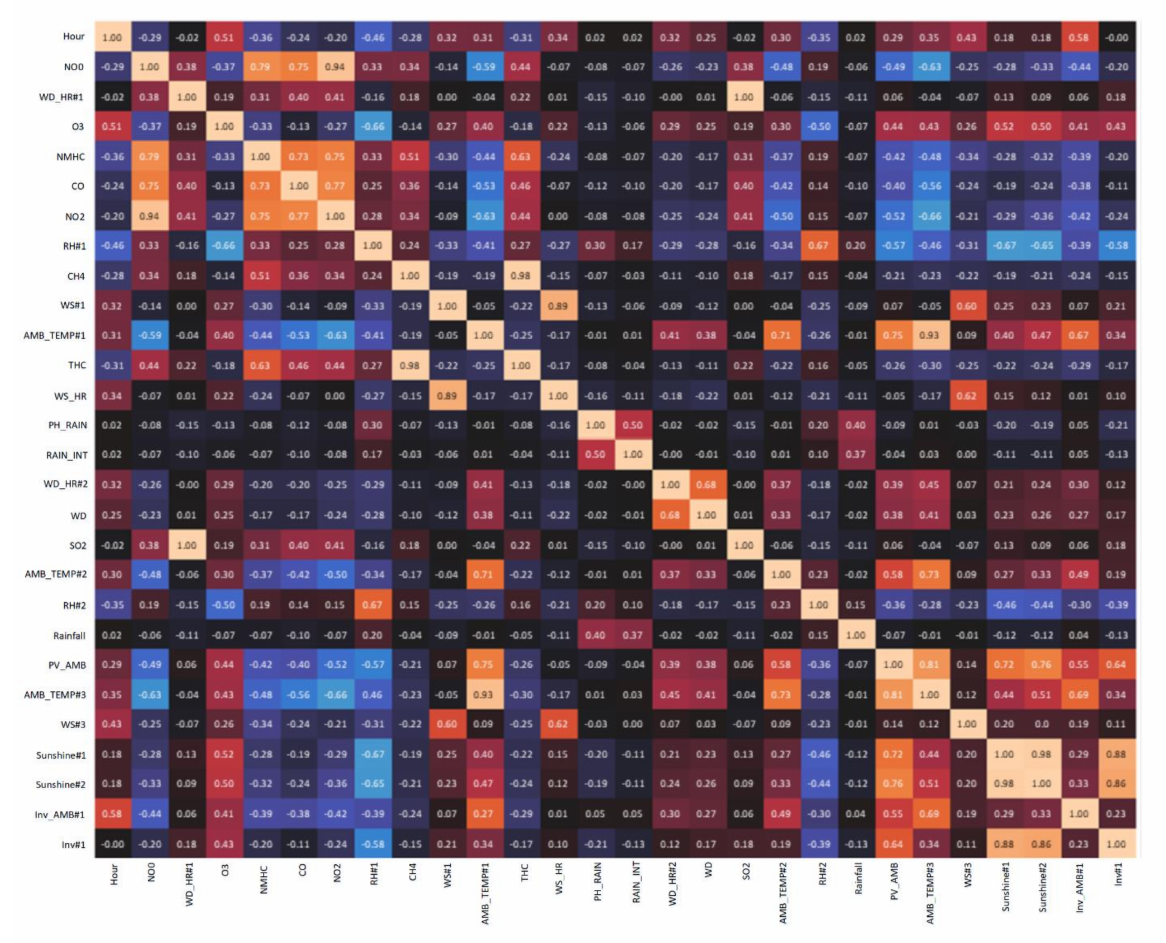
Figure 2. The resulting map of the Pearson correlation coefficient analysis.